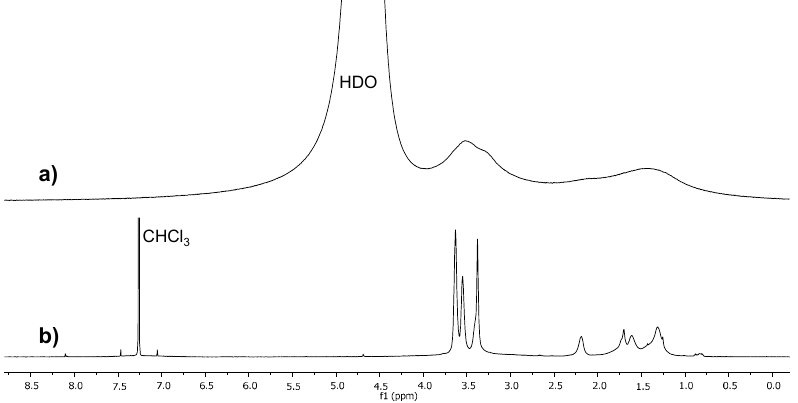
Figure 1. 1 H NMR spectra of ( a ) NP-C8TEG / C8-DO3AGd-a in D 2 O (500 MHz) and ( b ) NP-C8TEG in CDCl 3 at 500 MHz.